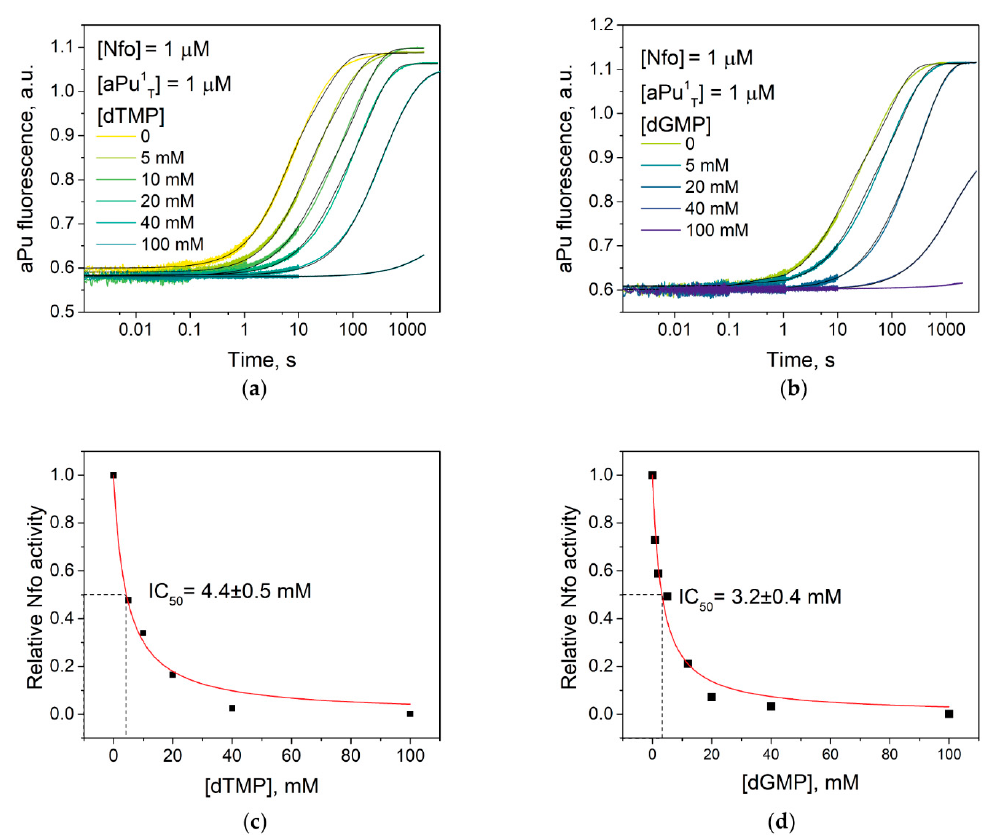
Figure 8. Changes in aPu fluorescence intensity over the course of interactions between Nfo and aPu 1T in the presence of dGMP ( a ) or dTMP ( b ). [aPu 1T ] = 1.0 μ M and [Nfo] = 1.0 μ M. The decline in Nfo activity depending on the concentration of dGMP ( c ) or dTMP ( d ) in the reaction